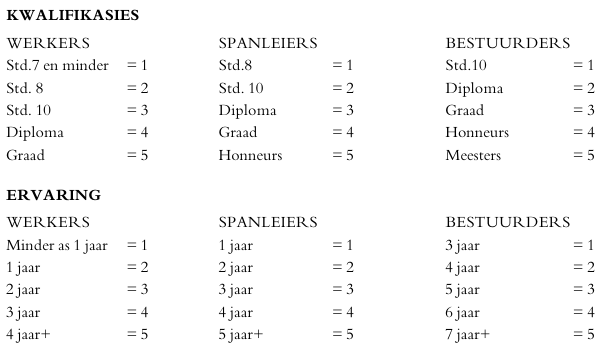
VERSKALING: KWALIFIKASIESENERVARINGVAN RESPONDENTE